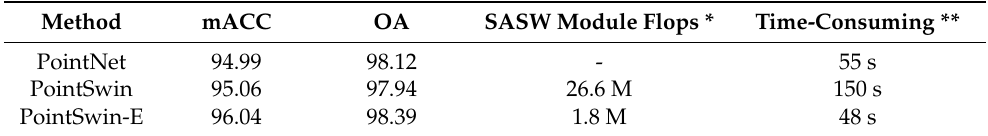
Table 2. Comparative experimental results of PointNet [6] and the two models of PointSwin on the ShapeNetPart dataset.